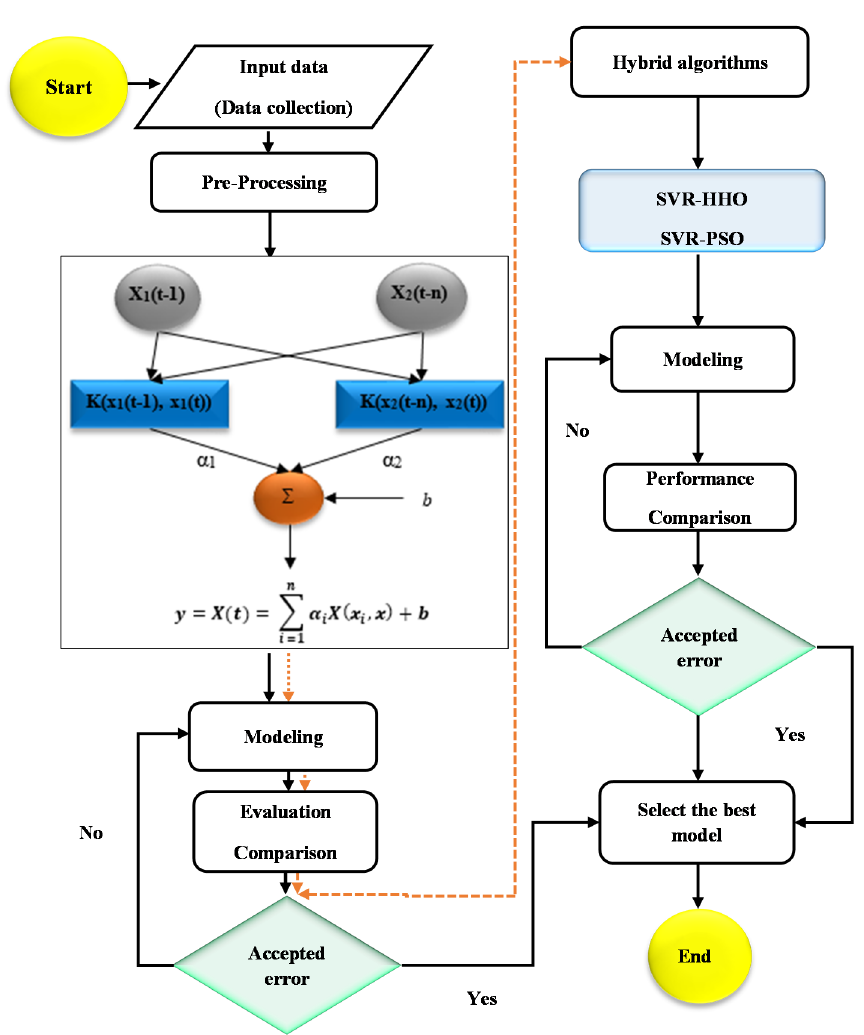
Figure 1. Proposed model development flowchart for this study.